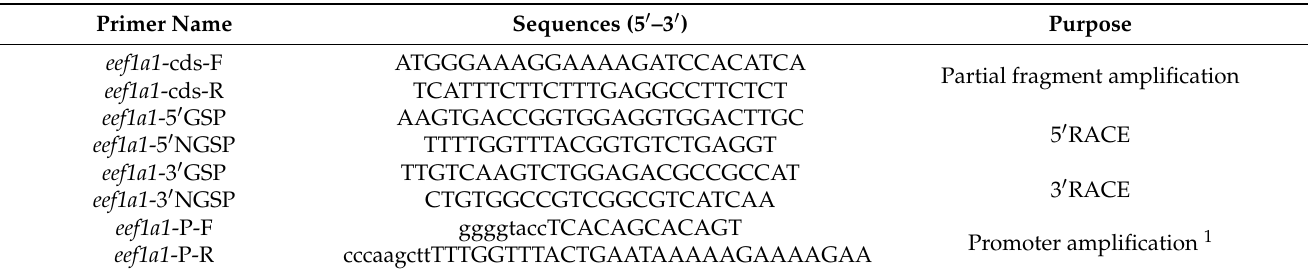
Table 1. Primers used in this